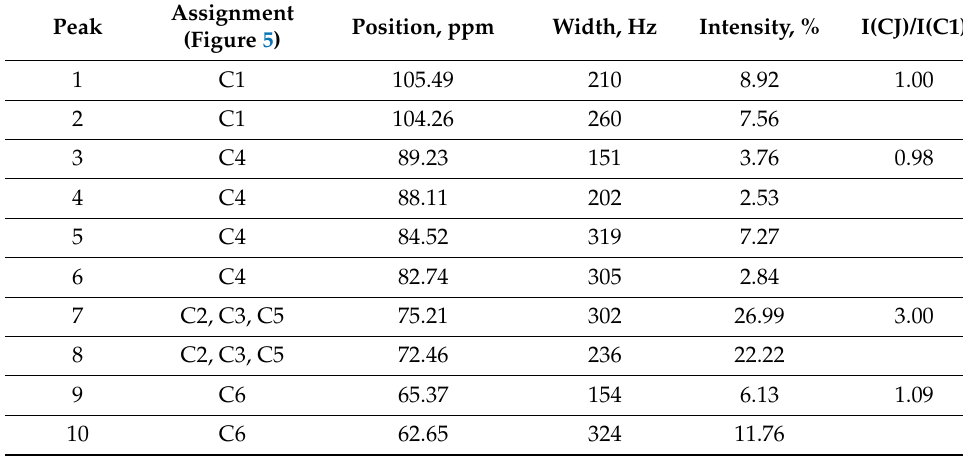
Table 4. Position, width, and intensity of individual peaks in the CP/MAS 13C NMR spectrum of the HogC